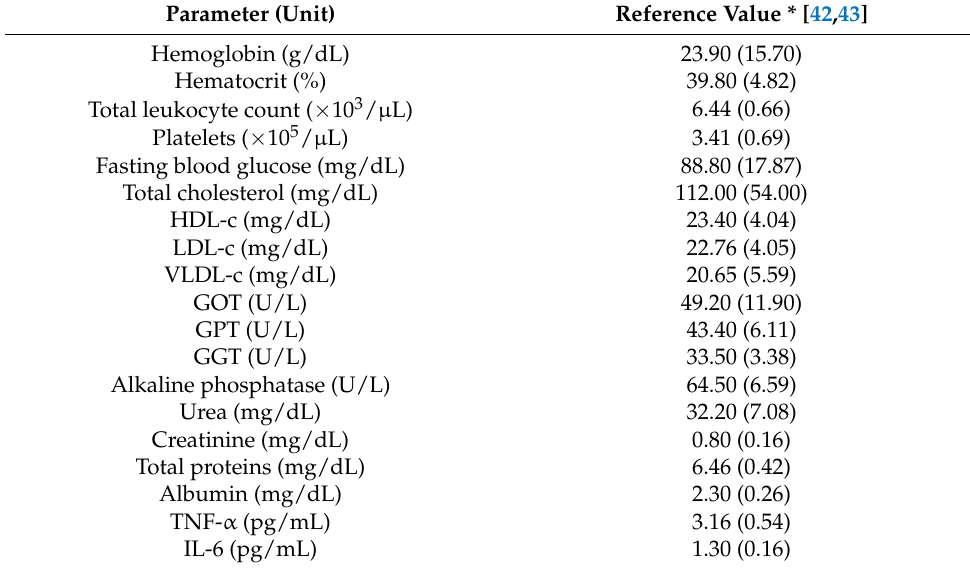
Table 1. Reference hematological, biochemical, and inflammatory parameters for male, adult, eu- trophic, and healthy Wistar rats acclimatized in the bioterium of Potiguar University, Natal, RN, Brazil,